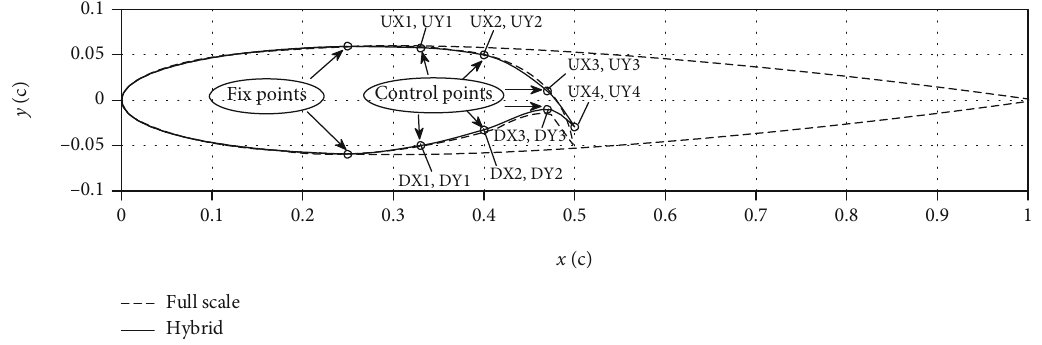
Figure 1: Full-scale geometry and control points of hybrid